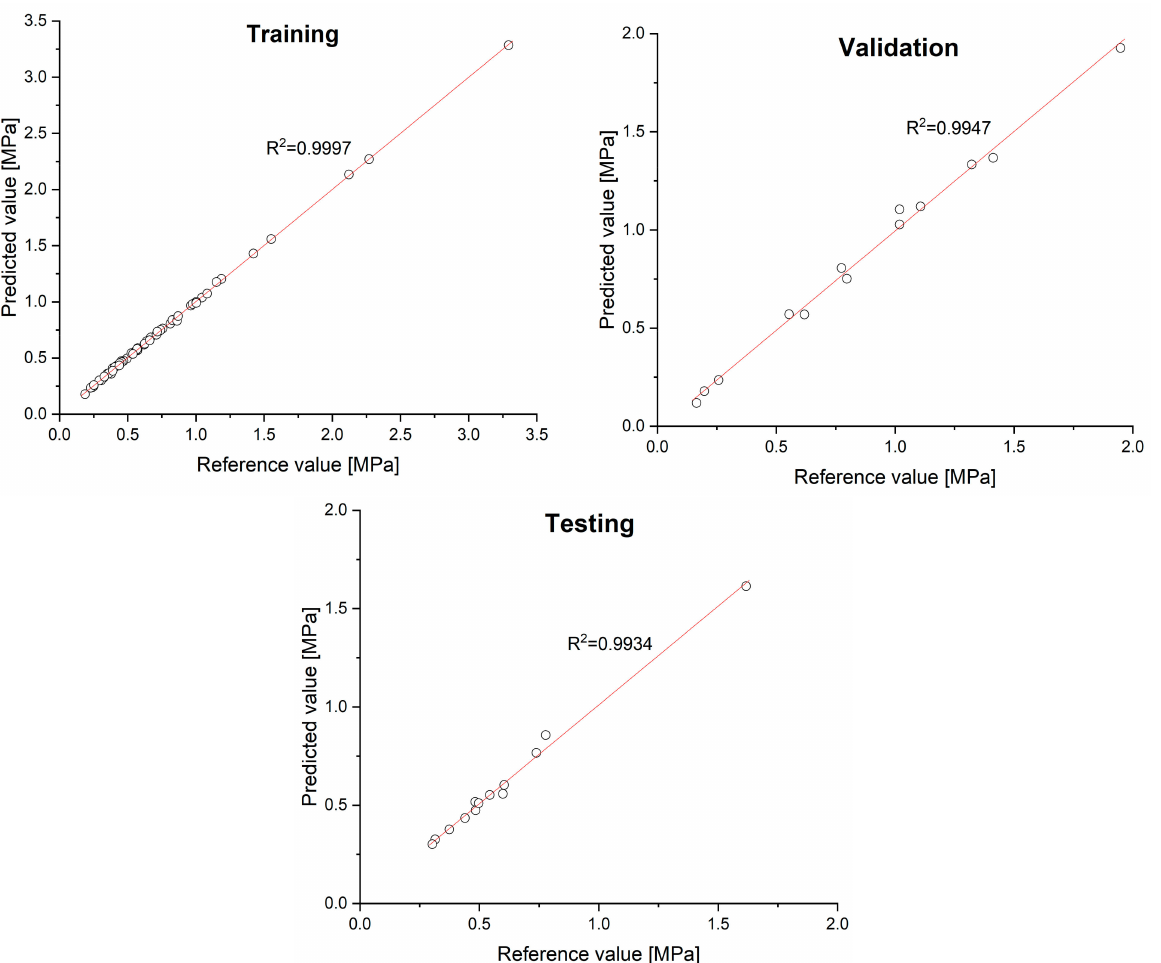
Figure 6. Dependencies between the values of the maximum methane seam pressure predicted by the neural network and the values determined for the training, validation and test sets.